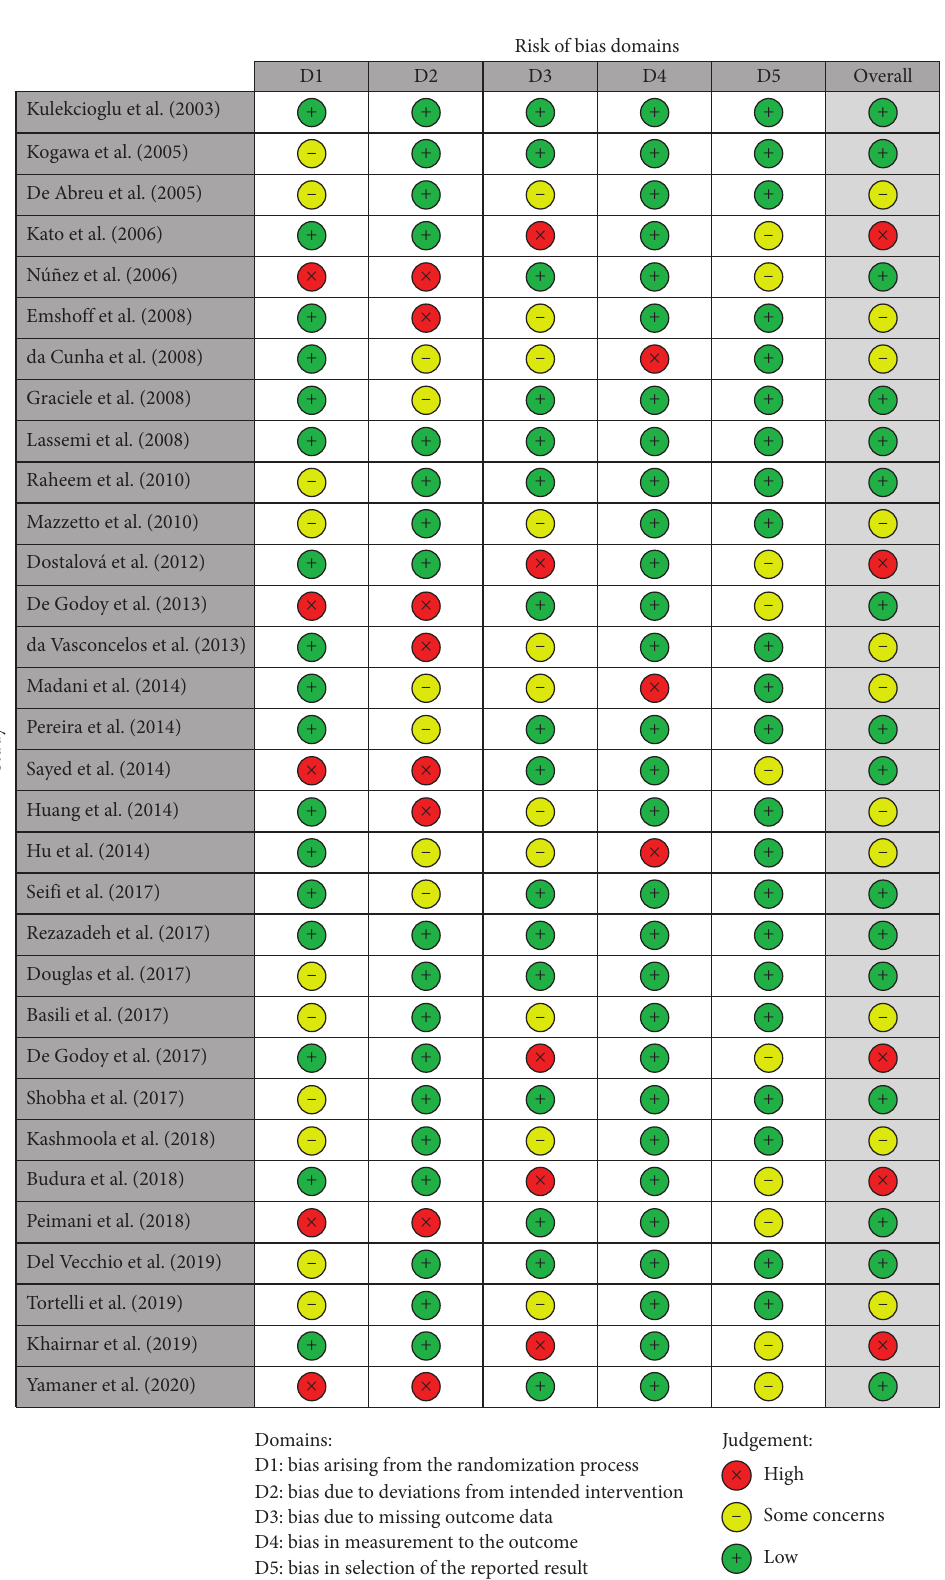
Figure 3: Risk of bias assessment of the